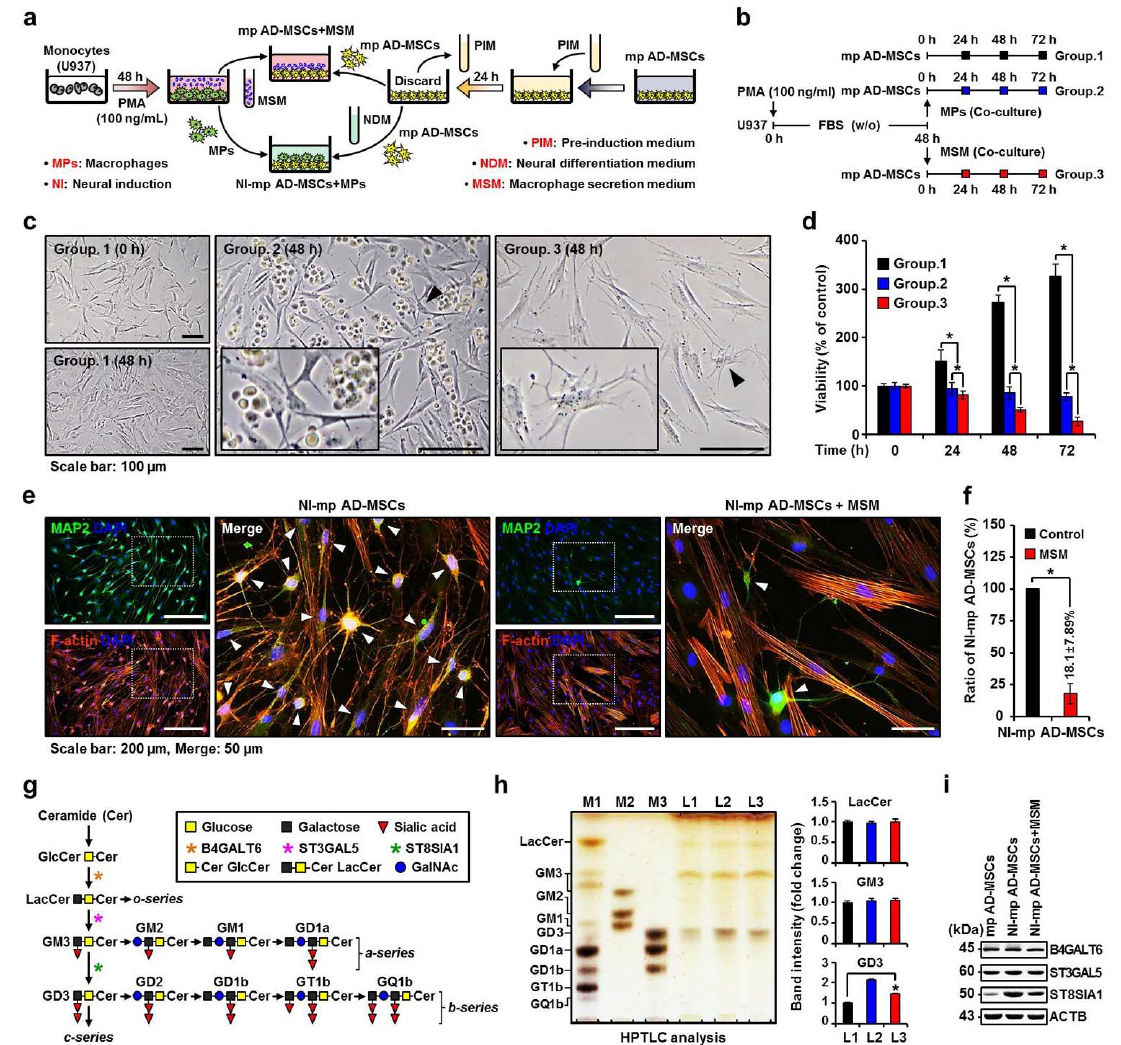
Figure 1. Expression patterns of gangliosides in the in vitro xenogeneic stem cell transplantation immune model. ( a ) The experimental setup to mimic xenogeneic stem cell transplantation in vitro. Human U937 cells were either used as monocytes or differentiated into MPs by incubation with 100 ng/mL PMA. ( b ) We used MPs and MSM, which were collected for 48 h in serum-free medium. Groups 1, 2, and 3 indicate the control, MP co-culture, and MSM co-culture, respectively. In a direct co-culture system, MPs were directly added to mp AD-MSC cultures. ( c ) Phase-contrast images of the co-culture system between mp AD-MSCs with MPs or MSM for 48 h. Arrowheads indicate enlarged images. ( d ) Cell proliferation was quantified by an MTS assay at 24, 48, and 72 h post-co-culture. Data are presented as mean percentage levels ± SD ( n = 3; * p < 0.05). ( e ) Immunofluorescence staining of neuronal induction (NI)-mp AD-MSC culture (control) and co-culture with MSM using MAP2-FITC, F-actin, and DAPI. White squares indicate enlarged merged images; arrowheads indicate induced neural-like cells. ( f ) Variations in the cell count of NI-mp AD-MSCs were quantified for co-cultures with or without MSM after 48 h. Data are presented as mean percentage levels ± SD ( n = 3; * p < 0.05). ( g ) General scheme for ganglioside synthesis; steps are also reversible. G: ganglioside; M: monosialo; D: disialo; numbers denote carbohydrate sequence. GlcCer: glucosylceramide; LacCer: lactosylceramide; GalNAc: N-acetylgalactosamine; B4GALT6, beta-1,4-galactosyltransferase 6; ST3GAL5, ST3 beta-galactoside alpha-2,3-sialyltransferase 5; ST8SIA1, ST8 alpha-N-acetyl-neuraminide alpha-2,8-sialyltransferase 1. ( h ) HPTLC of gangliosides in mp AD-MSCs (L1), NI-mp AD-MSCs (L2), or co-cultures with MSM (L3). M, marker; L, line; M1, adult mouse brain gangliosides; M2 and M3, ganglioside standard markers (left panel); quantification of band intensity of LacCer, GM3, and GD3 (right panel). Data are presented as fold changes ± SD ( n = 3; * p < 0.05). ( i ) Western blots for gangliosides LacCer, GM3, and GD3 synthase. Expression patterns of B4GALT6, ST3GAL5, and ST8SIA1 in mp AD-MSCs, NI-mp AD-MSCs, or co-cultures with MSM. ACTB was used as a loading